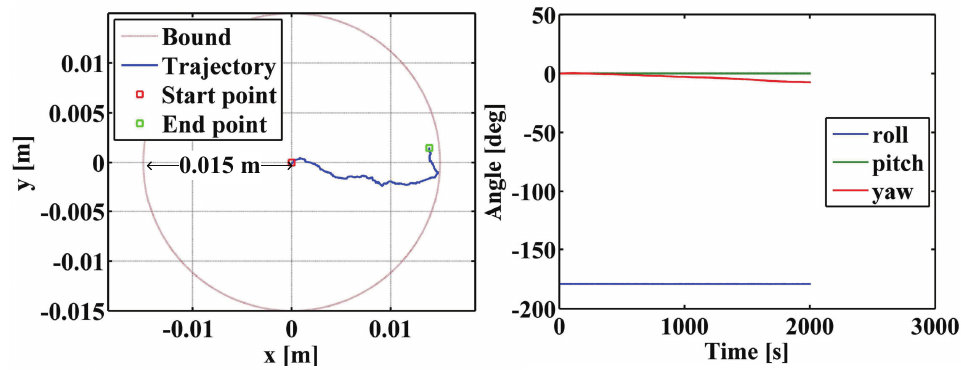
Figure 2. Position and attitude computed by the ZUPT-aided pedestrian navigation system (PNS) when the sensor (Mtw Awinda) stays still for half an